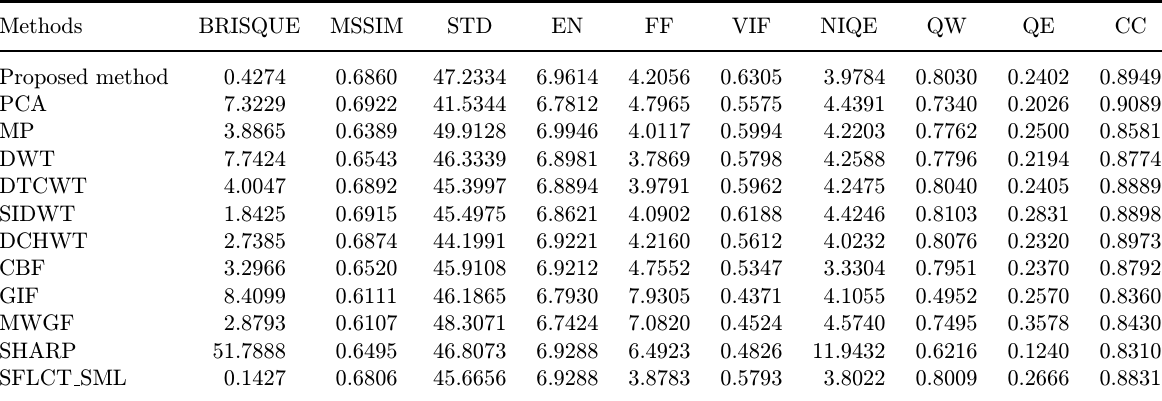
Table 3. Performance comparison for the third group of medical